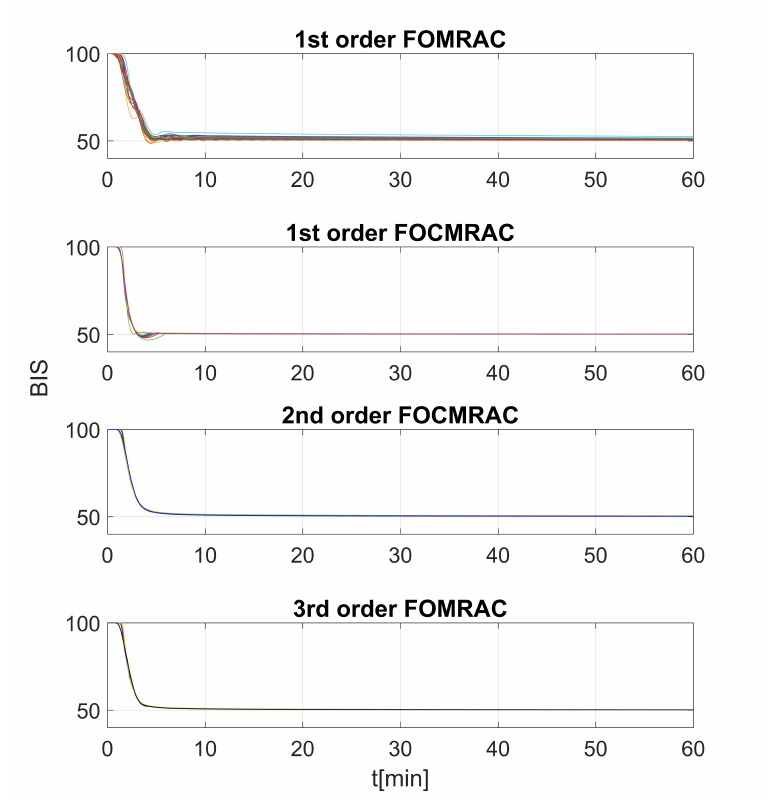
Figure 9. BIS output of the 30 virtual patients with the FOMRAC and FOCMRAC